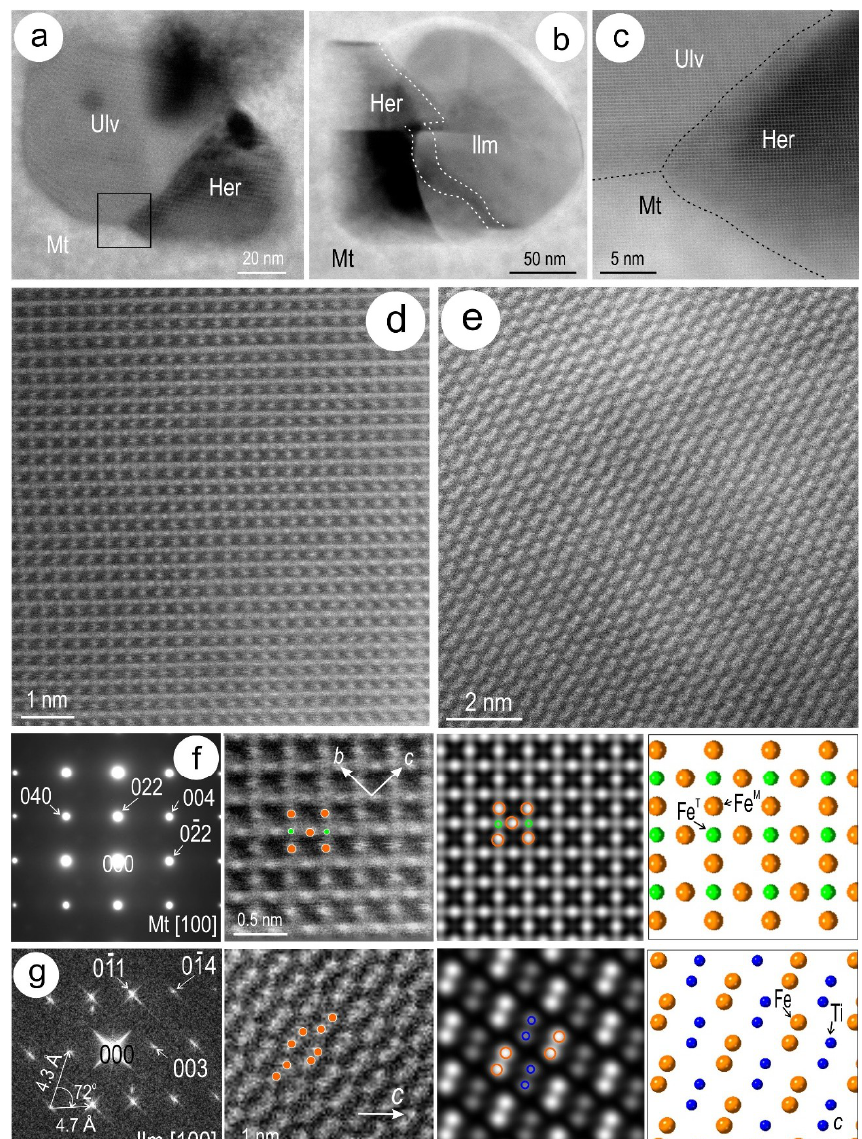
Figure 12. HAADF STEM images ( a – e ) showing associations between inclusions in magmatic magnetite (foil #8). These show binary associations between the Ti- and Al-spinels, ulvöspinel (Ulv) and hercynite (Her) in (a) or hercynite and ilmenite (Ilm) in (b). The darkest areas in (a, b) are holes produced during the FIB milling. Epitaxial relationships between the phases and host magnetite (Mt) is shown in (c). (d, e) High-resolution images showing atomic arrangements in magnetite and ilmenite on [100] zone axis in each phase. ( f , g ) From left to right: indexed selected area of electron diffraction (SAED), HAADF STEM image, STEM simulation and crystal model for magnetite and ilmenite on [100] zone axis. In magnetite, Fe atoms in M and T sites are imaged as spots of different size and intensity. In ilmenite, only the Fe atoms are imaged as dumbbells arrays. The lighter Ti atoms are not captured in the present images.